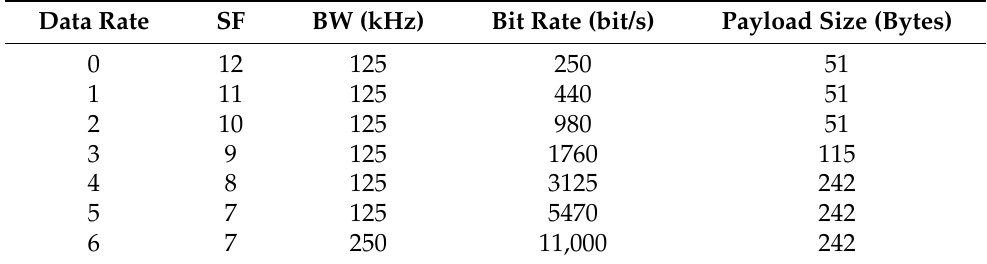
Table 7. EU863-870 Data Rates and Maximum Payload Size [123].